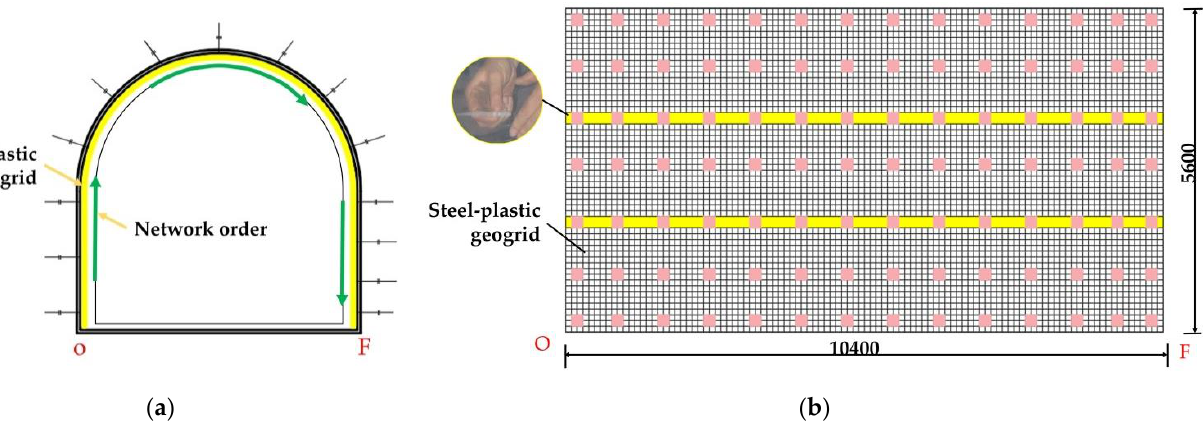
Figure 16. Diagram of steel-plastic geogrid laying construction: ( a ) schematic diagram of the profile; ( b ) schematic diagram of section unfolding.